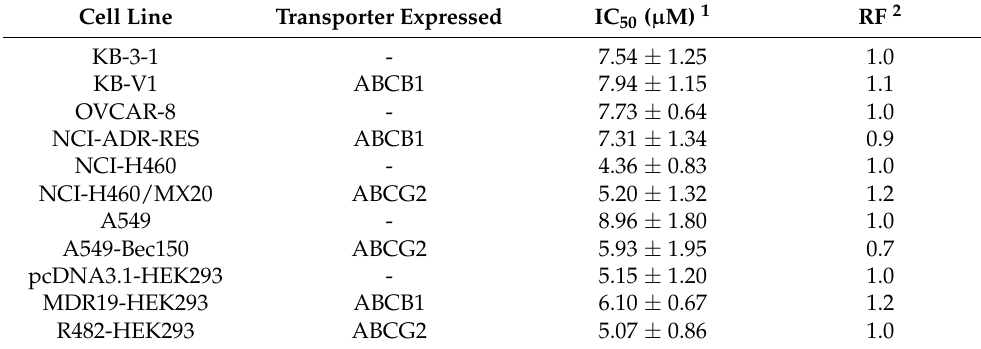
Table 1. The cytotoxicity of hydroxygenkwanin in human cell lines overexpressing ABCB1 or